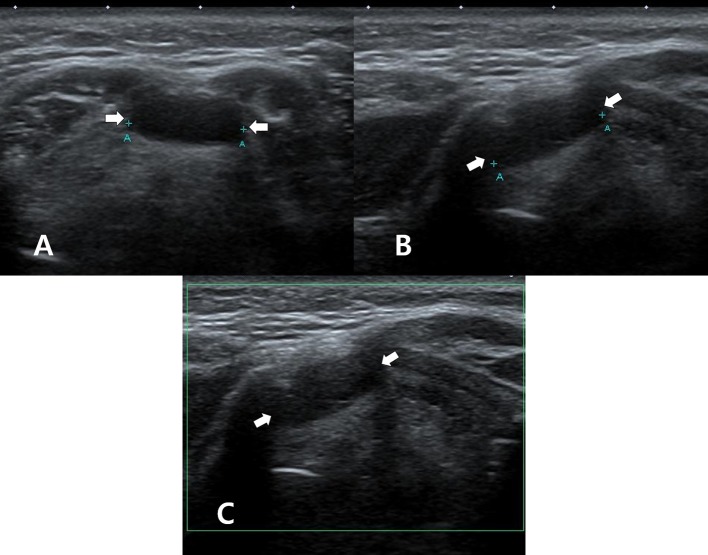
A 50~55-year-old woman who underwent thyroid ultrasonography (US) owing to health screening but had no history of thyroid surgery or radioactive iodine ablation. On thyroid US, transverse gray-scale (A), longitudinal gray-scale (B), and longitudinal color Doppler (C) US images show a well-defined cystic lesion with a flat-to-ovoid shape in the suprahyoid, anterior upper midline neck (arrows, 1.3 cm in length).